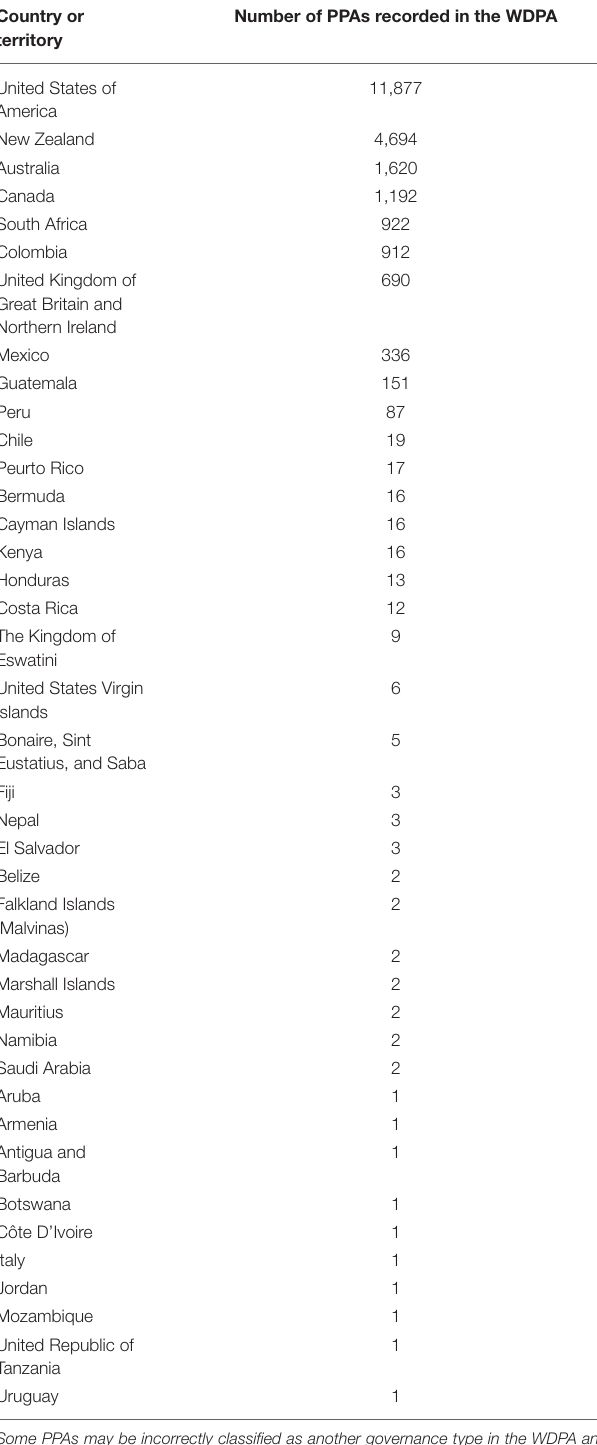
TABLE 1 | Countries and territories with data on PPAs recorded in the WDPA, June 2021 (UNEP-WCMC and IUCN, 2021a), based on records with the governance types “Individual landowners,” “For-profit organisations,” and “Non-profit organisations,” plus the New Zealand PPAs, which do not have a reported governance